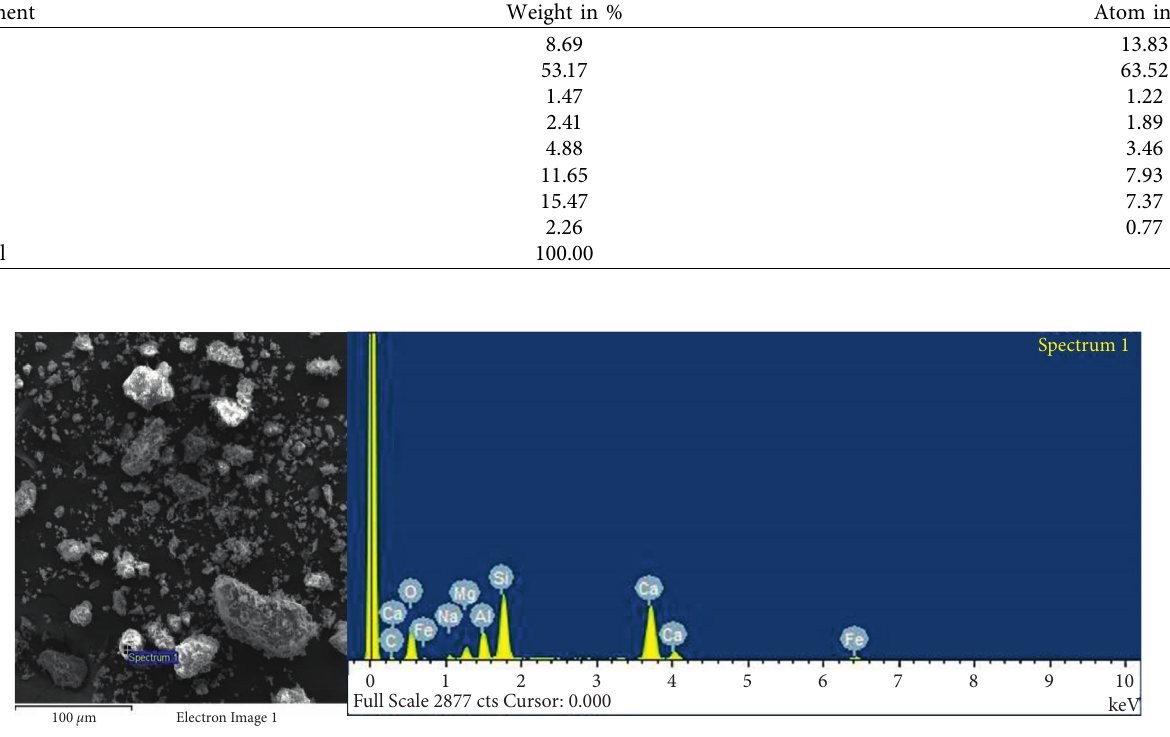
Figure 2: Semiquantitative analysis of FA power plant (Kosovo A) with SEM-EDX